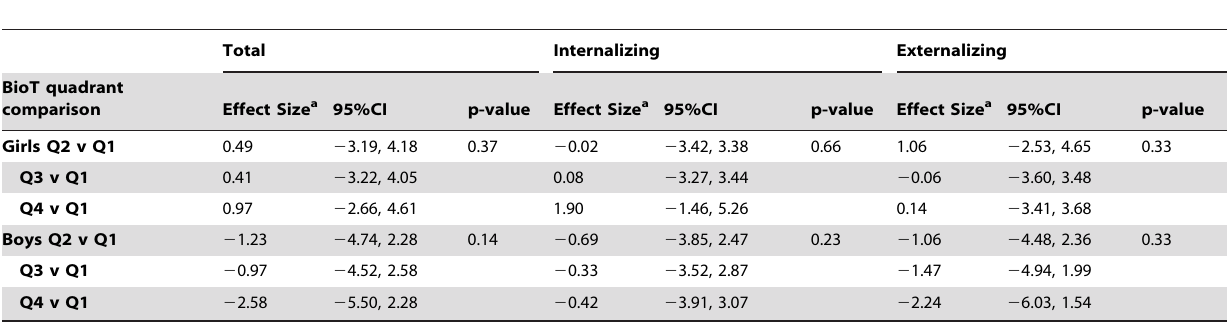
Table 2. Linear regression model of prenatal bioavailable testosterone (BioT) levels on CBCL T-scores at age 2 years.